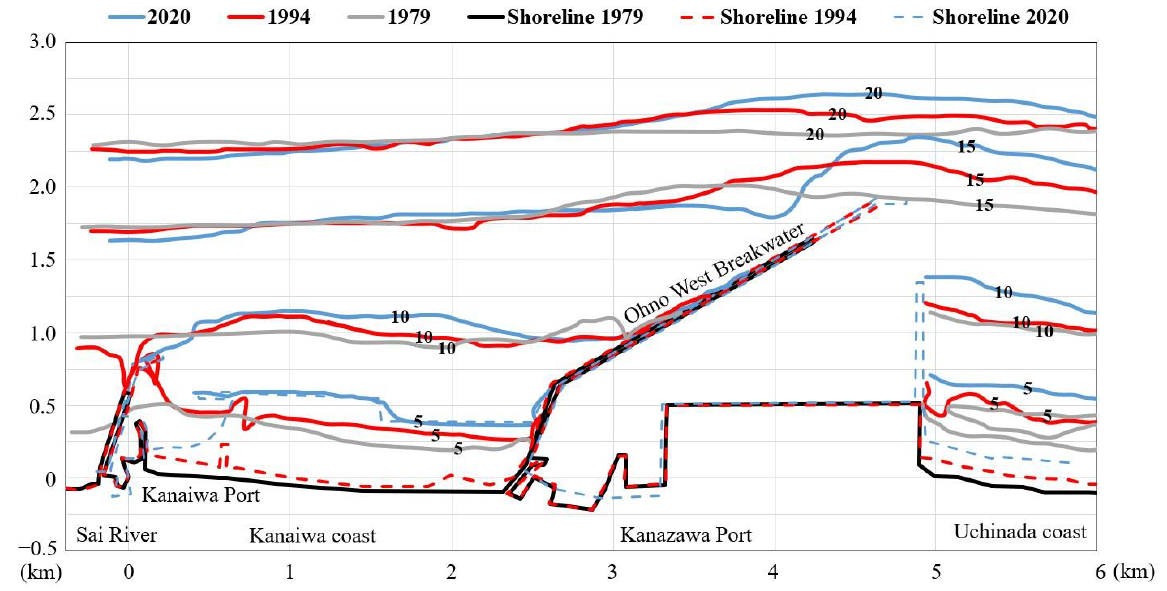
Figure 14. Long-term evolution of the bathymetric profile around Kanazawa Port. Water depth lines corresponding to 5, 10, 15, and 20 m, with the shoreline for 1979, 1994, and 2020.